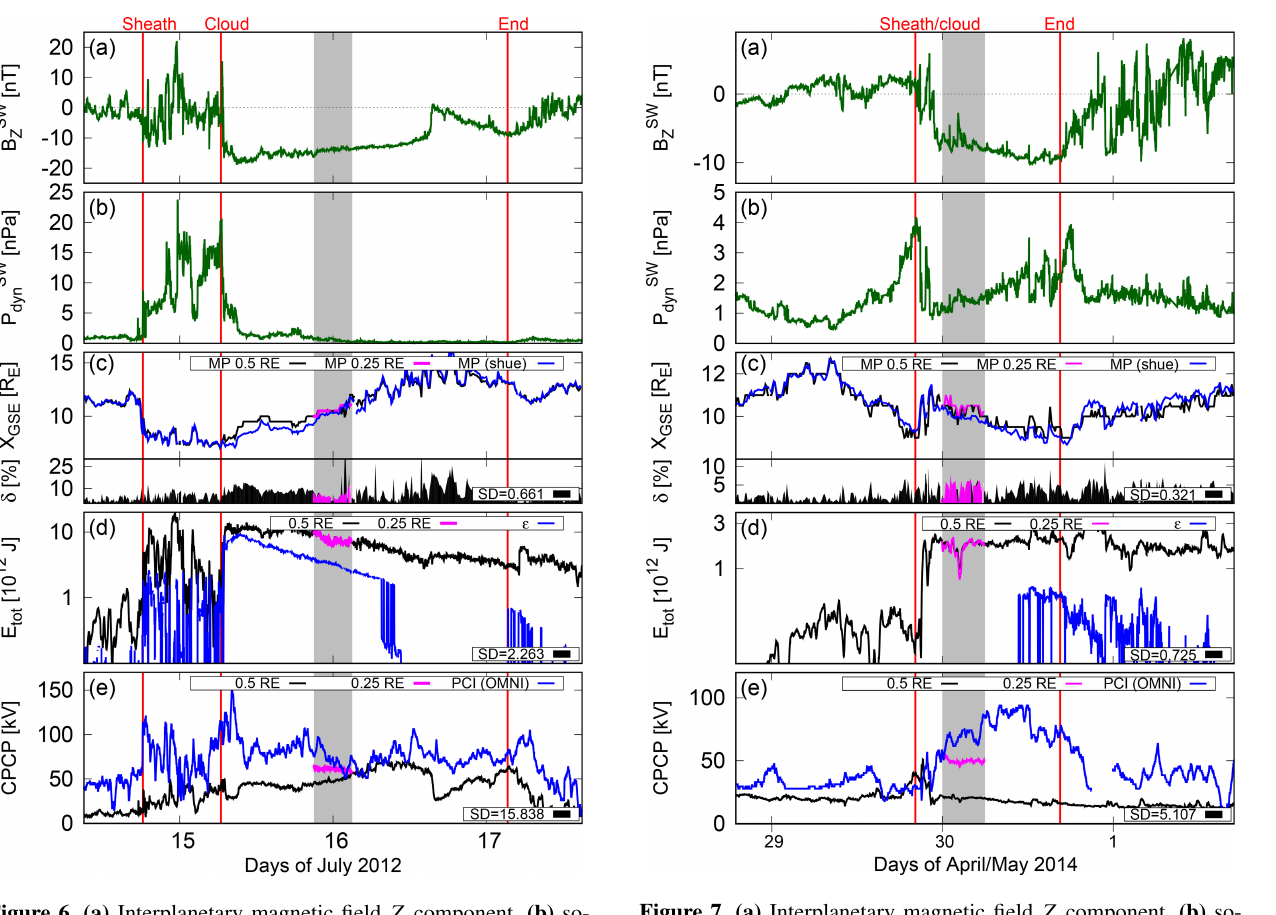
Figure 6. (a) Interplanetary magnetic field Z component, (b) so- lar wind dynamic pressure, (c) distance to the nose of the magne- topause, (d) energy transferred from the solar wind into the magne- tosphere through the dayside magnetopause, and (e) the cross-polar cap potential during 15 July 21:00UT–16 July 03:00UT, 2012. Ma- genta plots in panels (c) – (d) show results with a maximum spatial resolution of 0.25 R E . Blue curves in panels (c) , (d) , and (e) show the reference values (the Shue model, the (cid:15) parameter, the PCI). The relative difference magnitude δ between GUMICS-4 and the refer- ence value is shown in panel (c) . SDs for reference vs. GUMICS-4 (0.5 R E resolution) datasets are given in panels (c) – (e) .